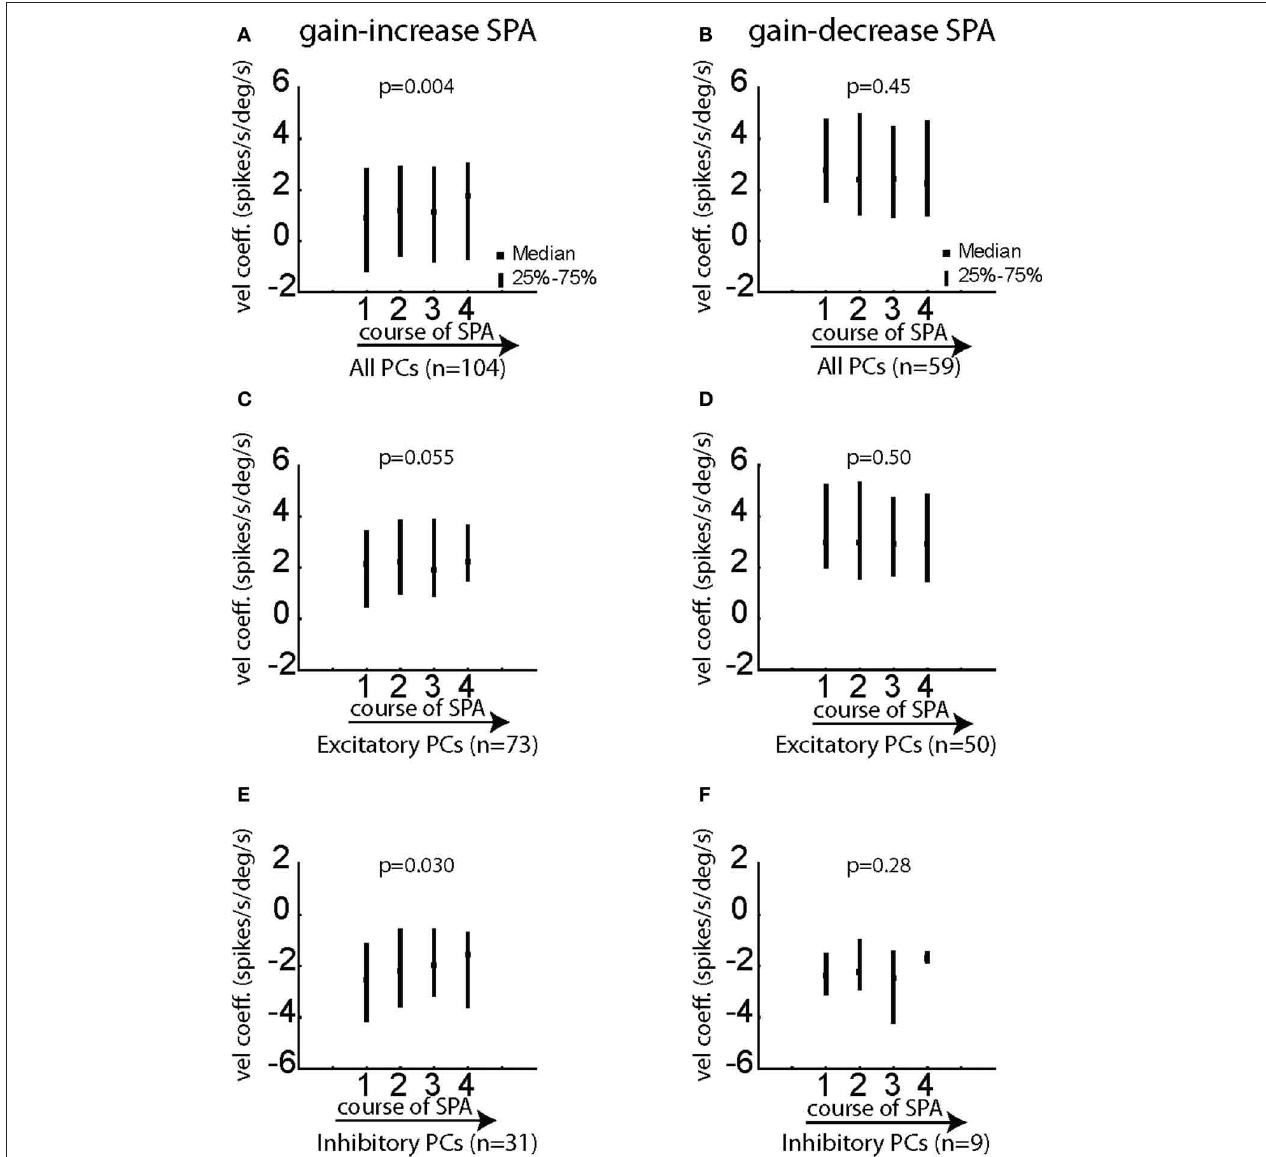
FIGURE 9 | Changes of the velocity coefficient b in the equation [spk( t − (cid:2)) = f × vel ( t ) + h ] for various subgroups of PC SS during gain-increase SPA (A,C,E) and gain-decrease SPA (B,D,F). (A,B) Show the median/quartile values of the velocity coefficient for the four bins covering the course of SPA for the entire population of PC SS during gain-increase SPA (A) and gain-decrease SPA (B) . (C , D) Show the changes of the velocity